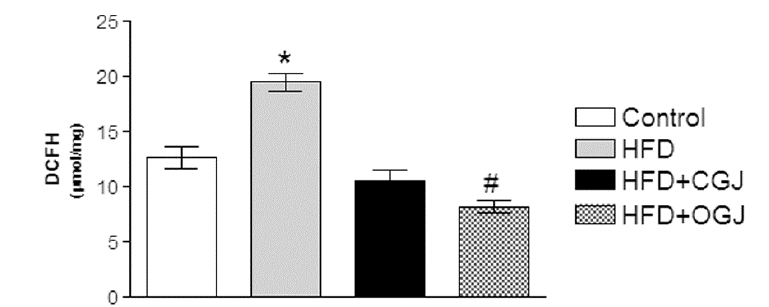
Figure 4. The effect of purple grape juices and high-fat diet on 2′,7′-dihydrodichlorofluorescein (DCFH) oxidation in the liver of rats. Values are the means ± SD for 8–10 samples in each group. Statistically significant differences were determined by ANOVA followed by the Tukey test: * p < 0.05, different from the other groups; # p < 0.05, different from the